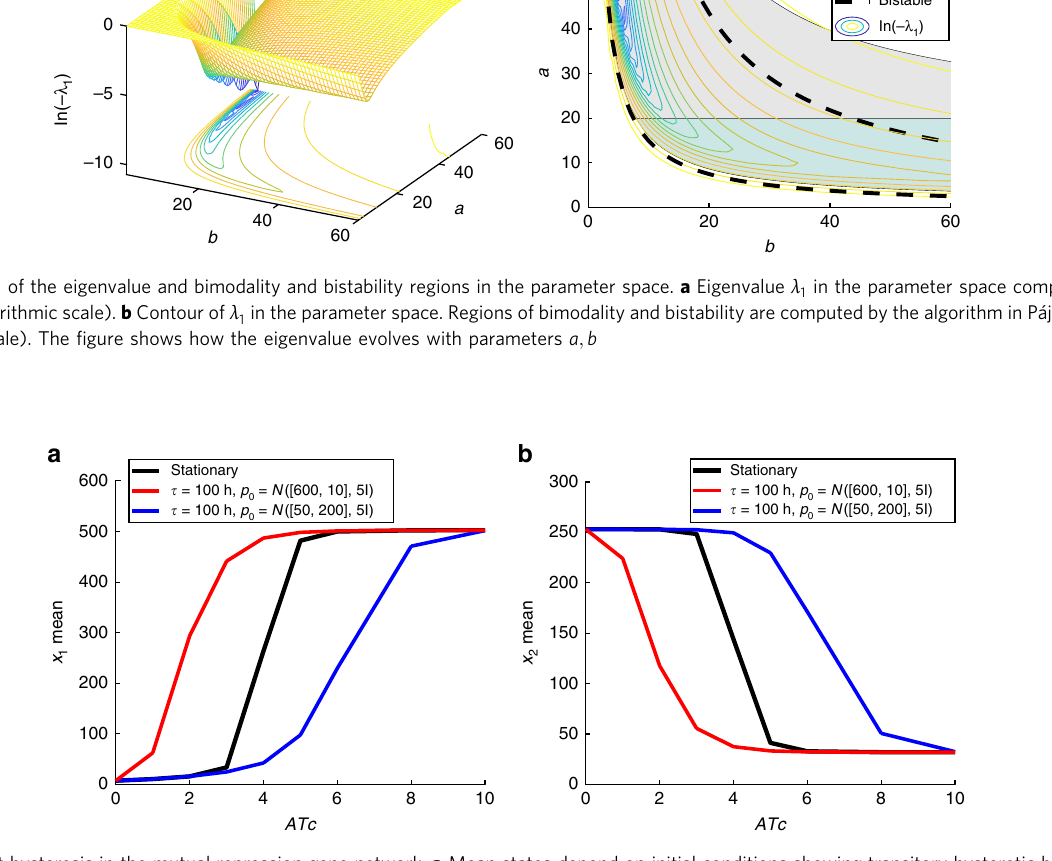
Fig. 4 Transient hysteresis in the mutual repression gene network. a Mean states depend on initial conditions showing transitory hysteretic behavior for LacI. b Mean states depend on initial conditions showing transitory hysteretic behavior for TetR. Red and blue lines are transient solutions ( t ¼ 100 h) obtained from two different initial conditions in the form of multivariate Gaussian distributions Nð μ ; Σ Þ with mean vector μ and covariance matrix Σ . When the system achieves the stationary state (black solid line corresponds to the stationary solution of the PIDE model), there is a unique mean x -value for given ATc (hysteresis disappears). Initial conditions were chosen to be near the peaks of the stationary distribution. Simulations have been carried out in